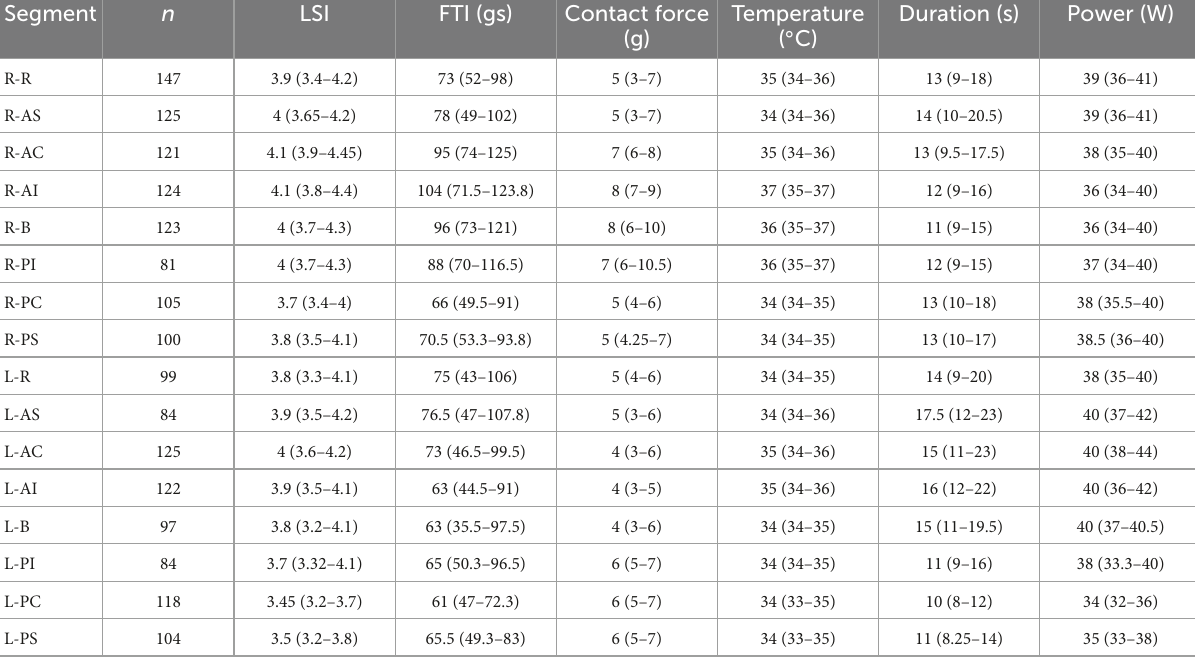
TABLE 2 Ablation parameters for each segment under the ablation